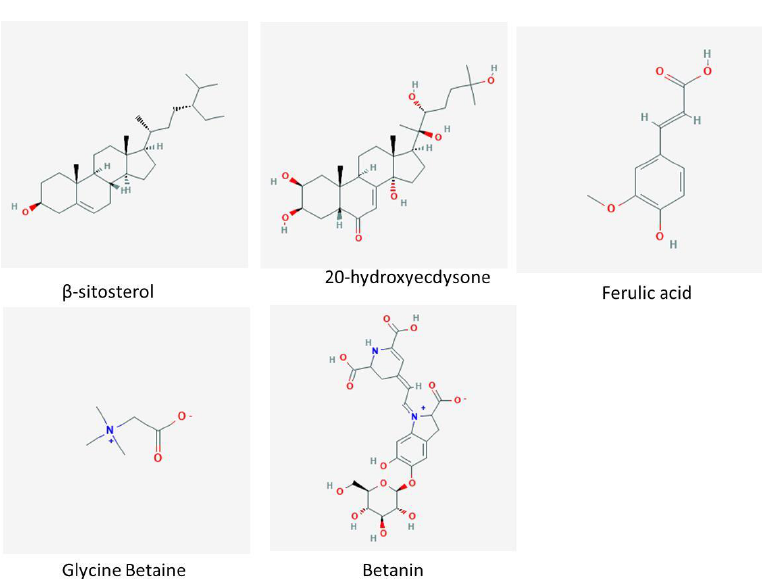
Figure 2. Secondary metabolites and bioactive molecules present in the quinoa grains.